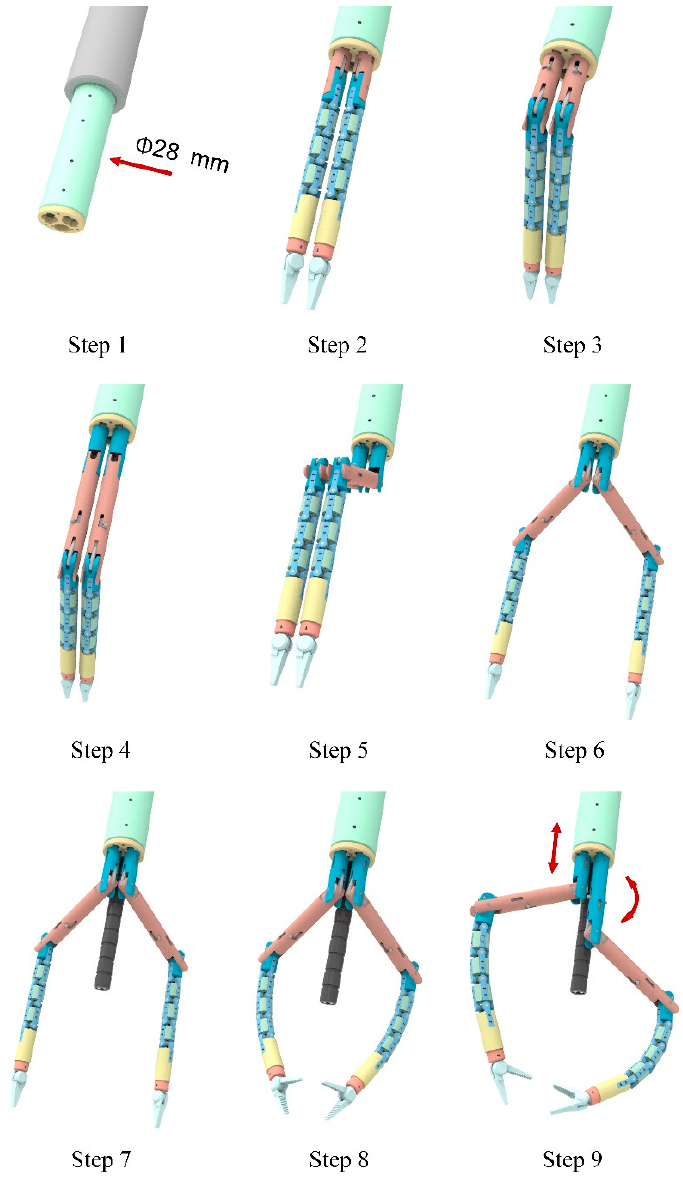
Figure 3. Workflow of the surgical instrument tube.